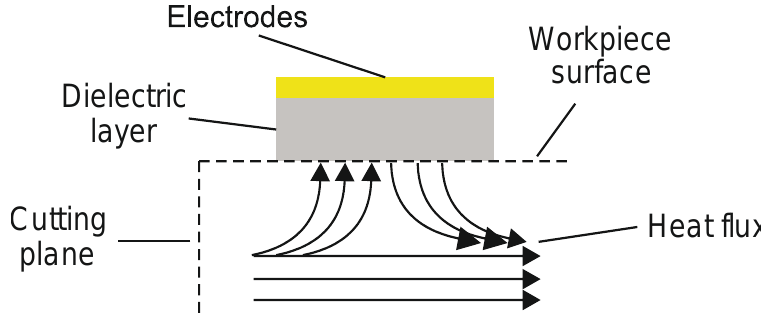
Figure 6. Setup of the simulation of the sensor signal from the heat flux in the workpiece.